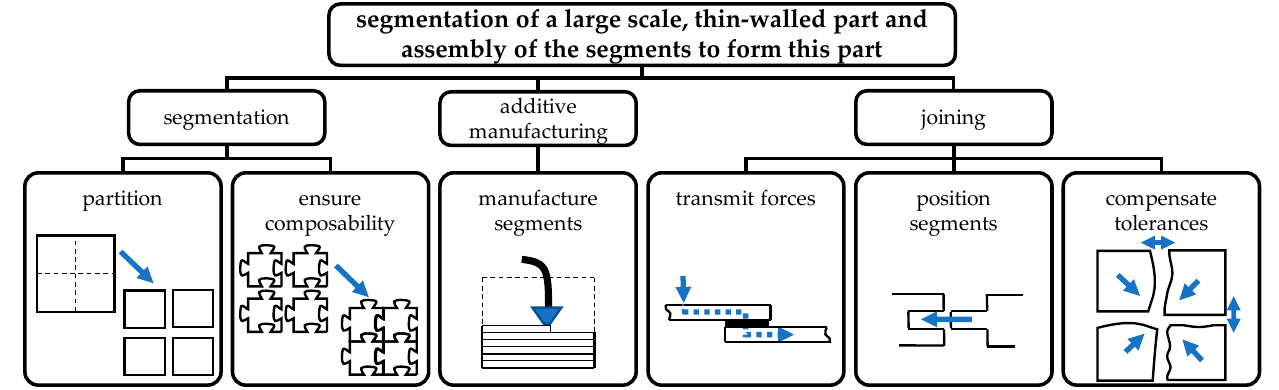
Figure 3. Structure of the developed method composed of three main functions.